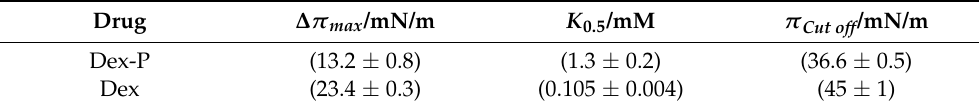
Table 1. Values of ∆ π max , K 0.5 , obtained from the hyperbolic fit show in Figure 1a (straight line) and exclusion pressure ( π cut off ) obtained from Figure 1b.